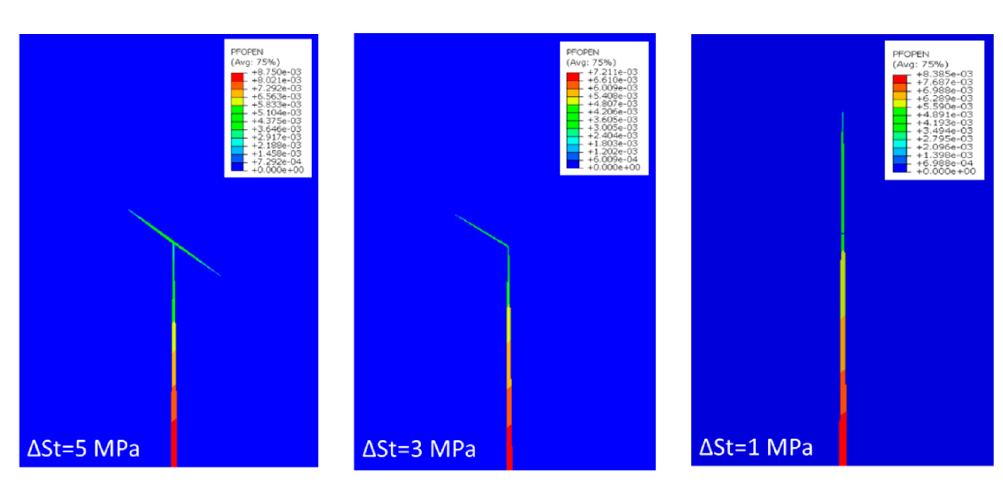
Figure 7. Crack geometry in difference tensile strength.